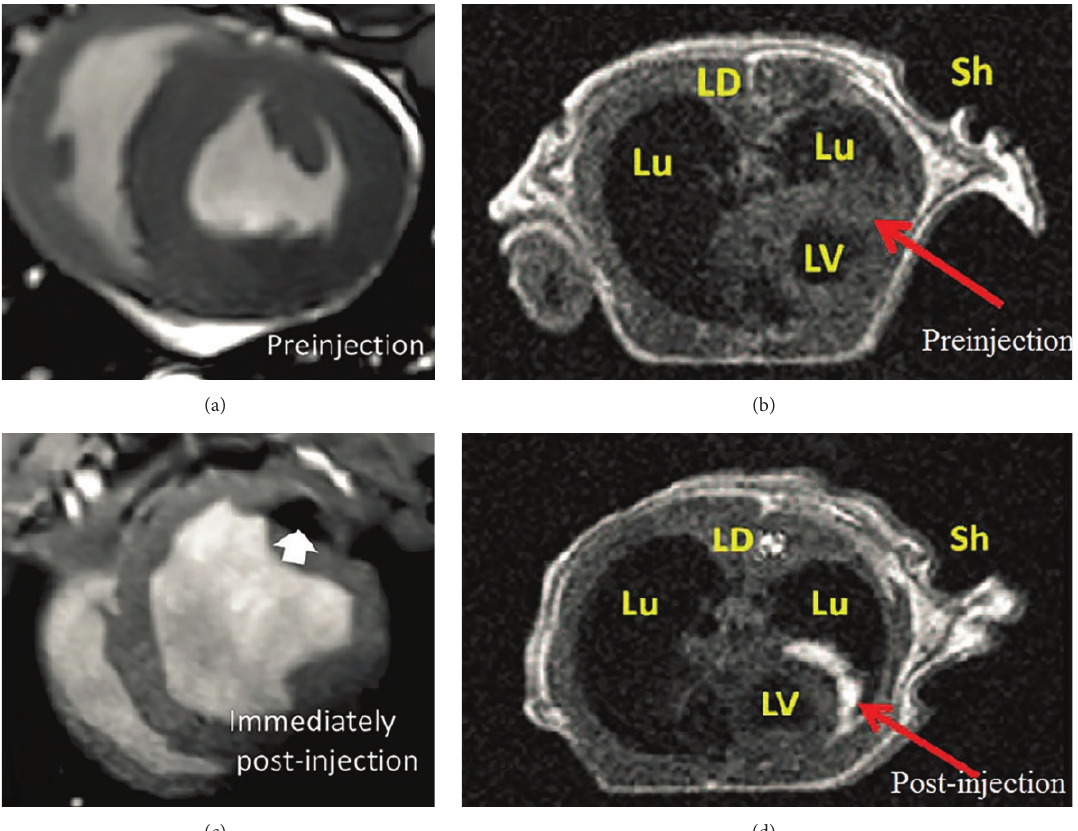
Figure 4: MR image of contrast agent labeled stem cells in preclinical models . (a), (b) are images taken before the therapy and (c), (d) are images taken after the injection of stem cells. Iron oxide nanoparticles were labeled to MSCs and highlighted the cells as darker color pointed by the arrowin image (c) whileGd 3+ nanoparticle highlighted the cells in bright color as shown by thearrowin image (d). LV: left ventricle; Lu: Lung; LD: lattisimus dorsi; Sh: Shoulder. (a), (c) are reprinted with permission of Wolters Kluwer Health, Inc. [87] and (b), (d) are reprinted with permission of the American Association for the Advancement of Science